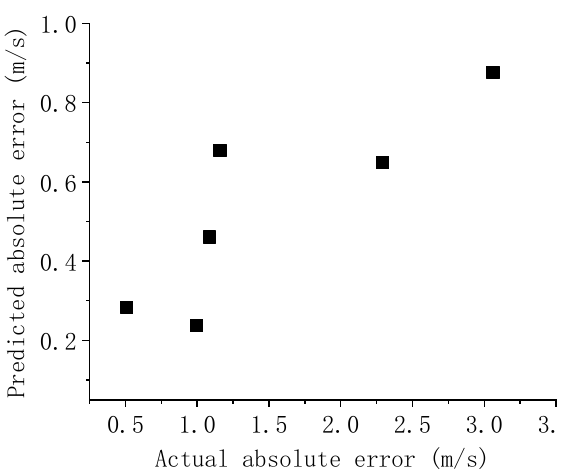
Figure 15. A comparison of the predicted and actual errors.